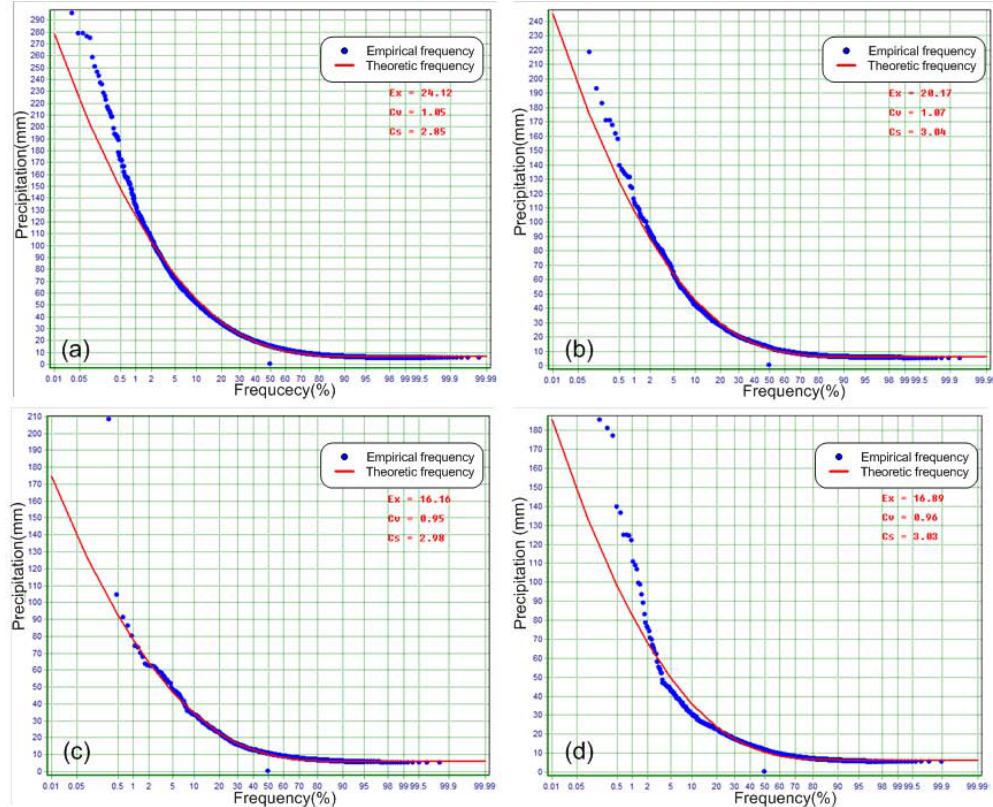
Fig. 5. Pearson-III curves of first precipitation after drought of different magnitudes in area I; (a) light drought; (b) moderate drought; (c) severe drought; (d) extraordinary